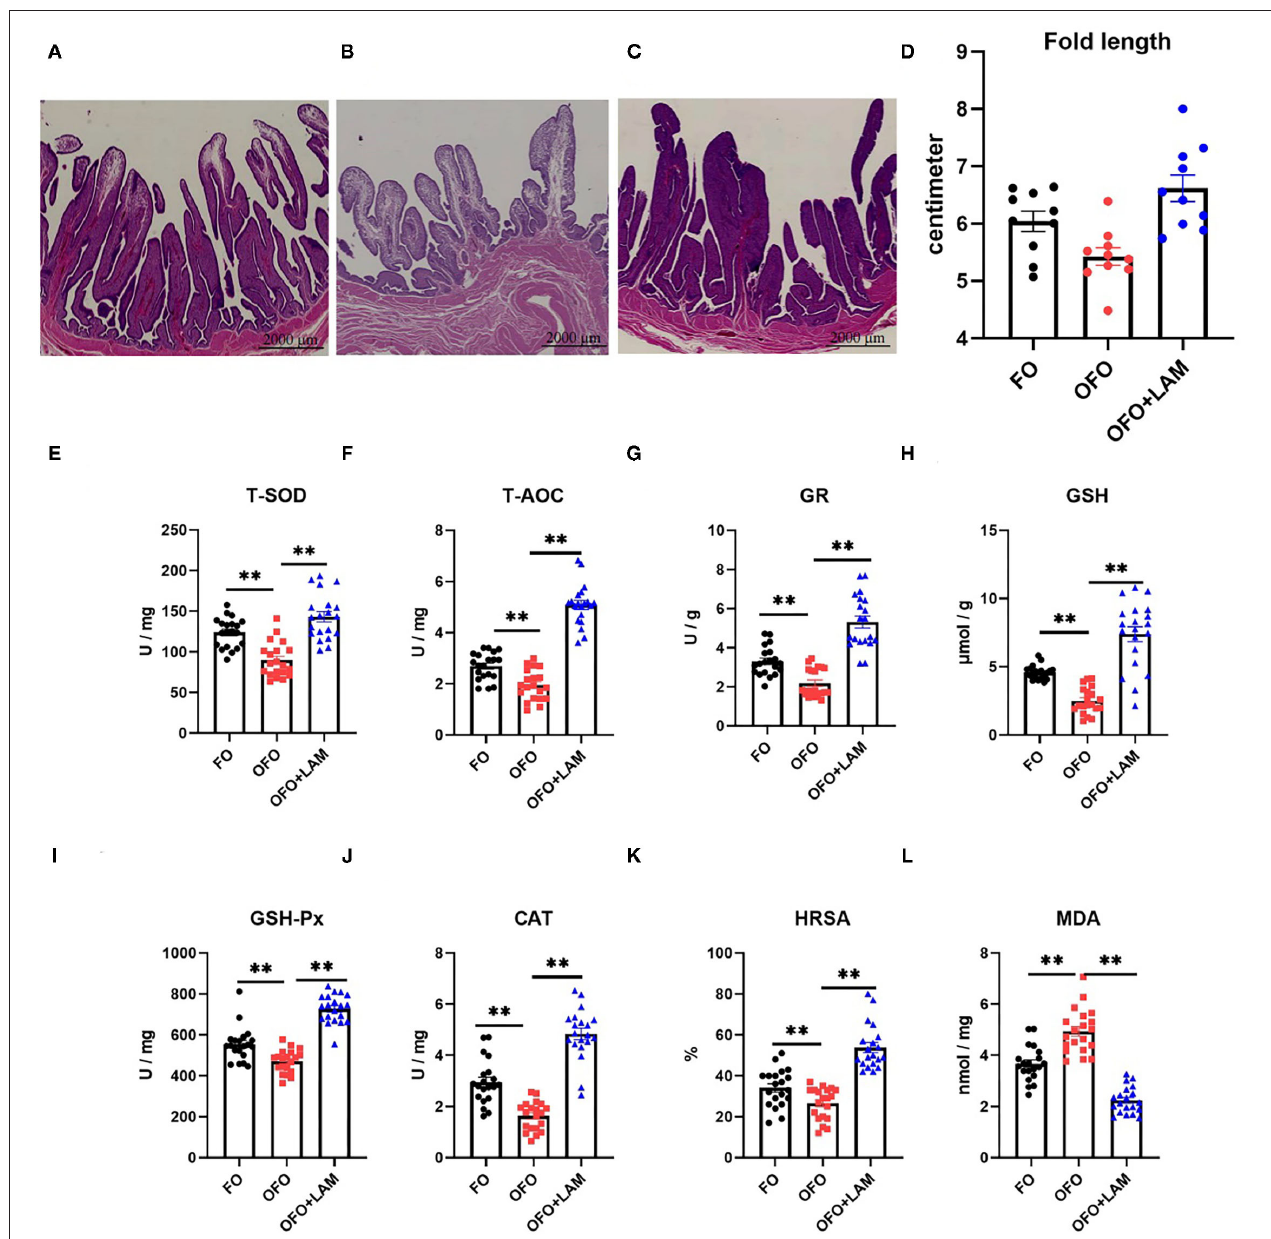
FIGURE 5 | The effect of FO, OFO, and OFO with LAM on uterine part structure and anti-oxidation. (A) FO group; (B) OFO group; (C) OFO + LAM group; (D) the fold length of uterine part in FO, OFO, and OFO + LAM group. Graphs were observed at 0.5 × , the size unit of the photograph is 2,000 µ m. (E) Content of T-SOD in FO, OFO, and OFO + LAM. (F) Content of T-AOC in FO, OFO, and OFO + LAM. (G) Content of GR in FO, OFO, and OFO + LAM. (H) Content of GSH in FO, OFO, and OFO + LAM. (I) Content of GSH-Px in FO, OFO, and OFO + LAM. (J) Content of CAT in FO, OFO, and OFO + LAM. (K) Content of HRSA in FO, OFO, and OFO + LAM. (L) Content of MDA in FO, OFO, and OFO + LAM. ** p < 0.01 and * p < 0.05 indicate significant differences between two